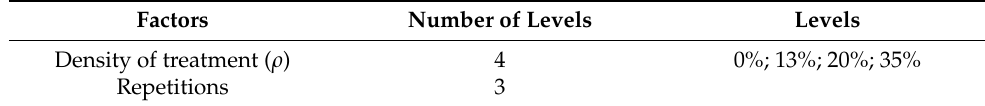
Table 3. Experimental plan.